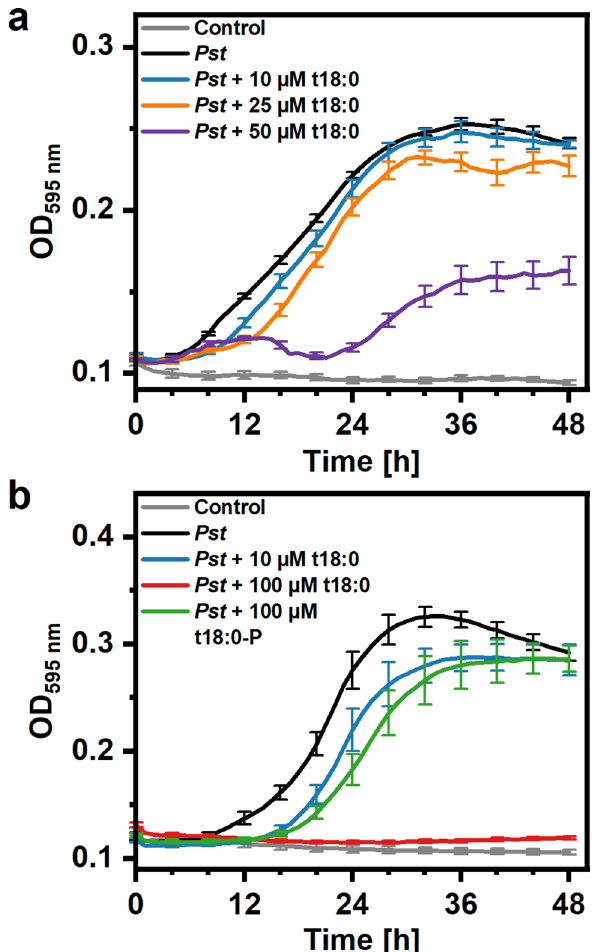
Figure 3. Phytosphingosine inhibits Pseudomonas syringae growth in liquid medium. Wells from cell culture plates with 0.2 mL of KB medium were inoculated with Pseudomonas syringae pv. tomato ( Pst ) DC3000 suspension (OD = 0.01) or a solvent control (2% DMSO in 10 mM MgCl 2 ) without bacteria. The medium either contained the indicated concentrations of phytosphingosine (t18:0), phytosphingosine-1-phosphate (t18:0-P), or solvent (2% DMSO) only. Plates were incubated under constant shaking at 28 °C for the indicated time in a plate reader. OD at 595 nm was measured each hour and values are means of 11 ( a ) or 8 ( b ) wells. Error bars indicating standard error of the mean (SEM) are depicted for values every four hours for better